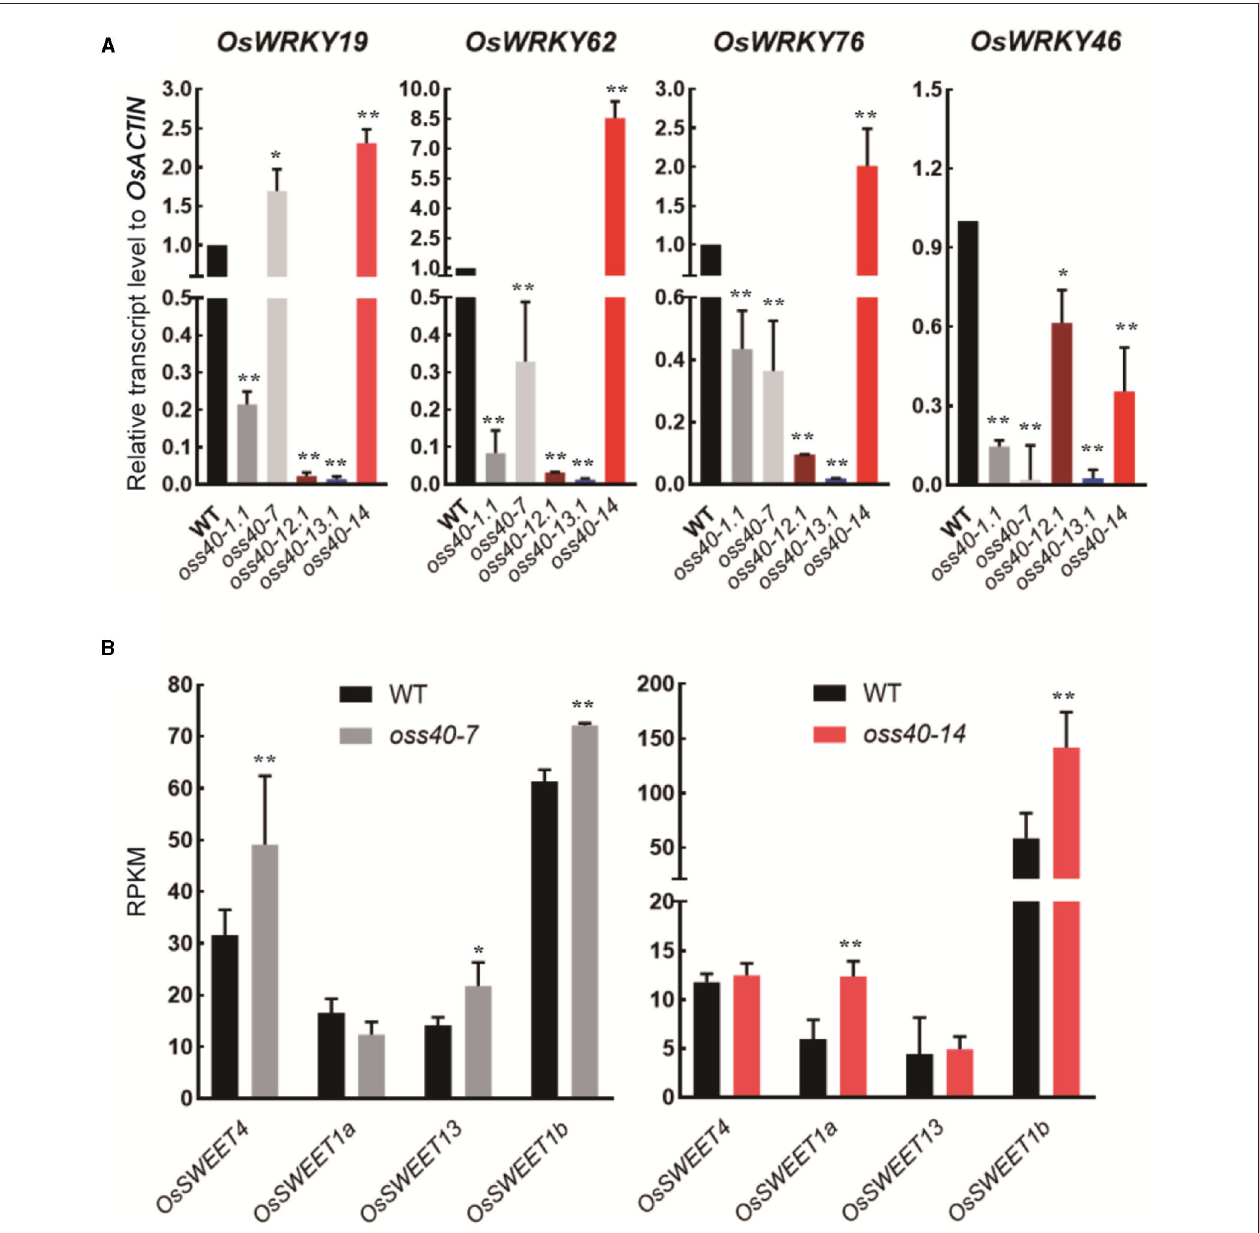
FIGURE 7 | Expression profiles of selected WRKY members and SWEET members in the stay-green oss40 mutants relative to WT (A) . Expression profiles of selected WRKY members ( OsWRKY19 , OsWRKY62 , OsWRKY76 , and OsWRKY46 ) in five stay-green oss40 mutants relative to WT (B) . Expression profiles (RPKM) of selected SWEET members ( OsSWEET1a, OsSWEET1b, OsSWEET4, and OsSWEET13 ) in the oss40-7 and oss40-14 mutants relative to WT based on the RNA-seq dataset of mutant and WT leaves at 77 days after sowing. The values are mean ± SD. Mean and SD values were obtained from three biological replicates. Significant differences of the expression levels normalized to WT were evaluated using Student’s t -test (* p < 0.05; ** p < 0.01).